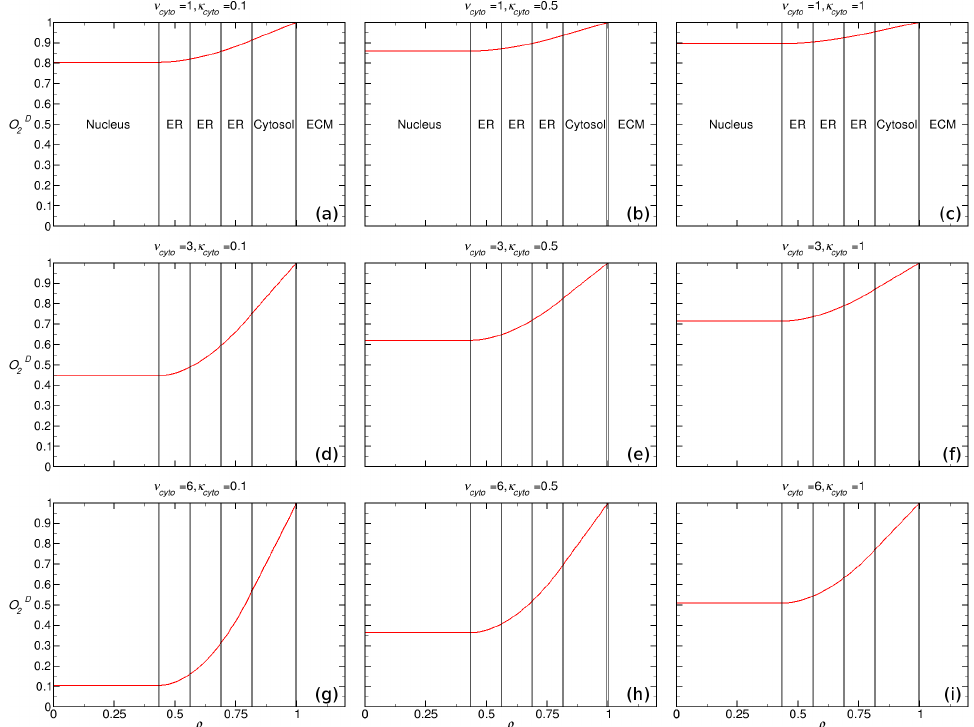
Figure 3. Intracellular oxygen concentration dependency on Michaelis-Menten parameters ( V max , cyto , K M , cyto ) represented in normalized form ρ = r ering 10 regions, R 1 the radial distance to outer cell membrane and C 0 is the constant ECM oxygen concentration surrounding the cell, where left-right κ cyto = 0.1,0.5,1.0 and top-down ν cyto =